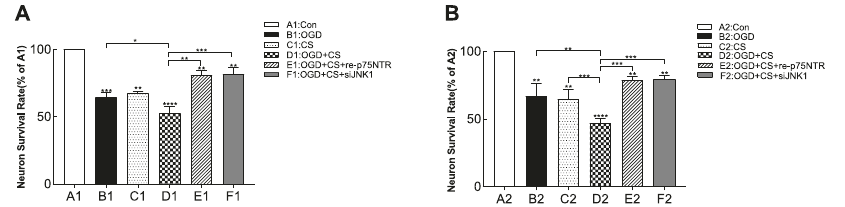
Fig. 2 Neuron survival rate using CCK-8 assay in six groups. ( n = 3 per group) 1, Prefrontal cortical neurons. 2, Hippocampal neurons. A Neuron survival rate of the prefrontal cortex. B Neuronal survival rate of hippocampal neurons. Data are expressed as a percentage of the control group. Data are presented as mean (columns) and SD (error bar). “ * ” on the top of each column represents the P value compared with the control group (Group A). * P < 0.05, ** P < 0.01, *** P < 0.001, **** P < 0.0001. Con control, OGD oxygen-glucose deprivation, CS corticosterone.